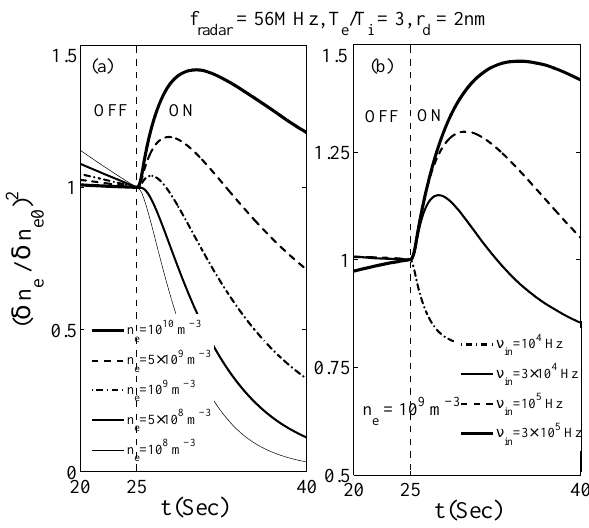
Fig. 2. The time evolution of electron irregularities during radio wave heating with varying (a) electron density and (b) ion-neutral collision frequency utilizing the computational model for a radar frequency of 56MHz. The heating is turned on at 25 seconds.